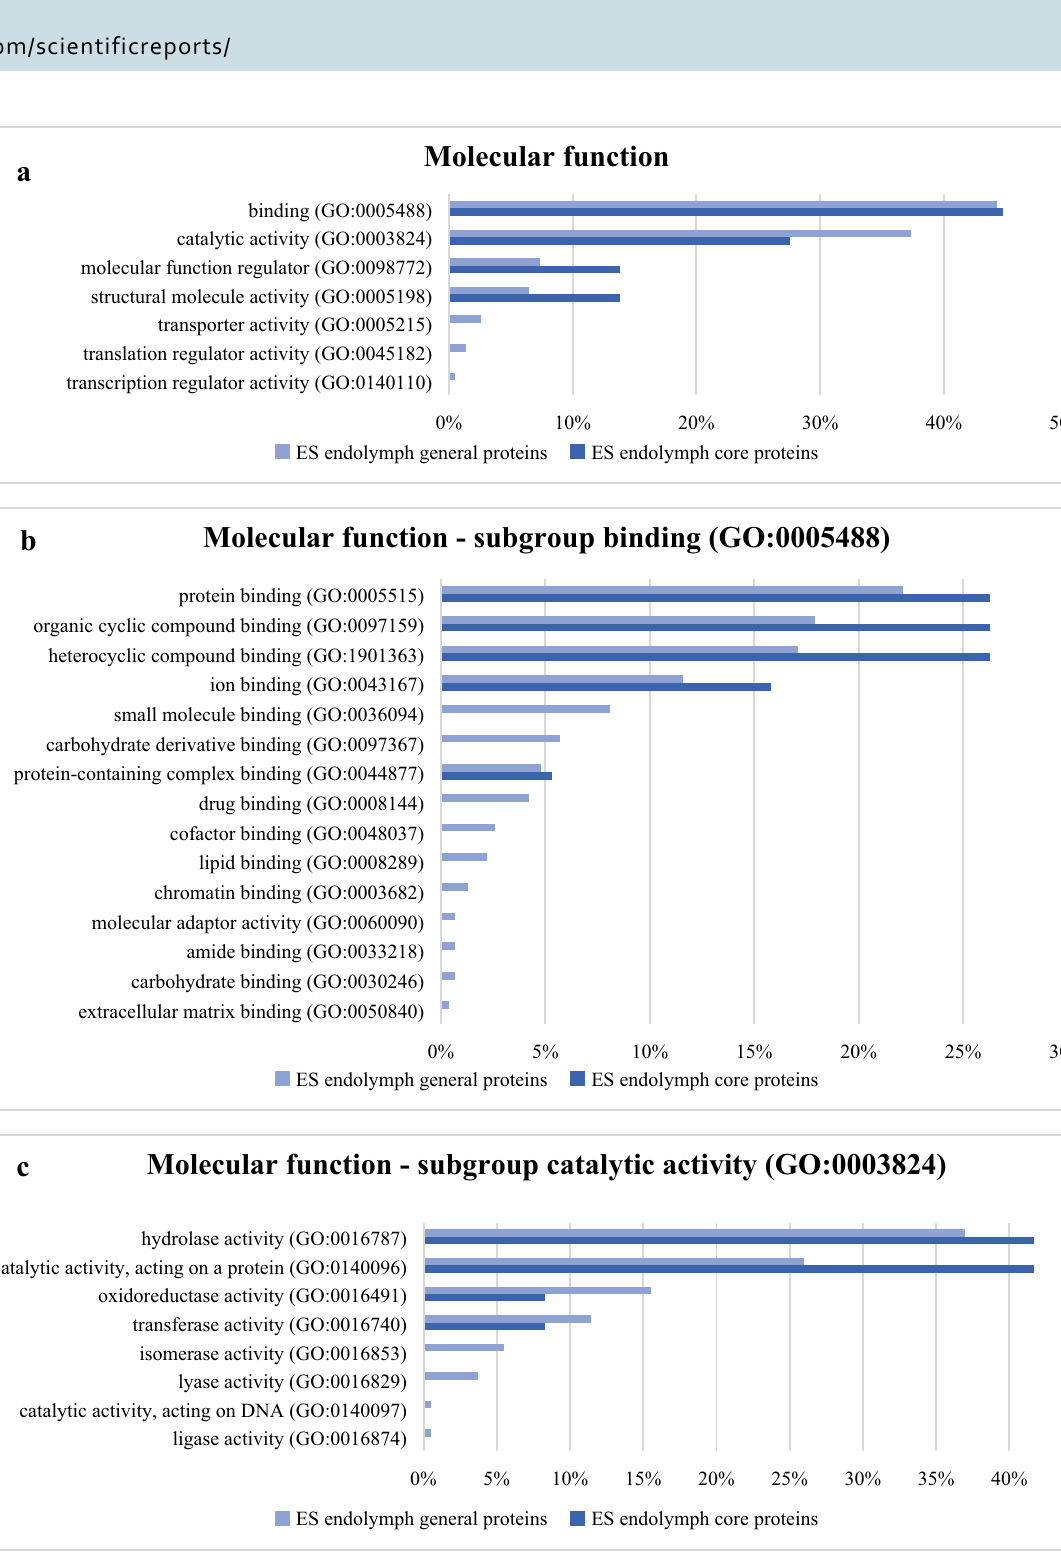
Figure 2. Molecular function according to PANTHER GO-slim amongst ES endolymph general proteins and ES endolymph core proteins. All results presented as a percent of identified proteins out of the total number of protein function hits. ( a ) Main group molecular function; ( b ) in the subgroup binding; ( c ) in the subgroup catalytic activity